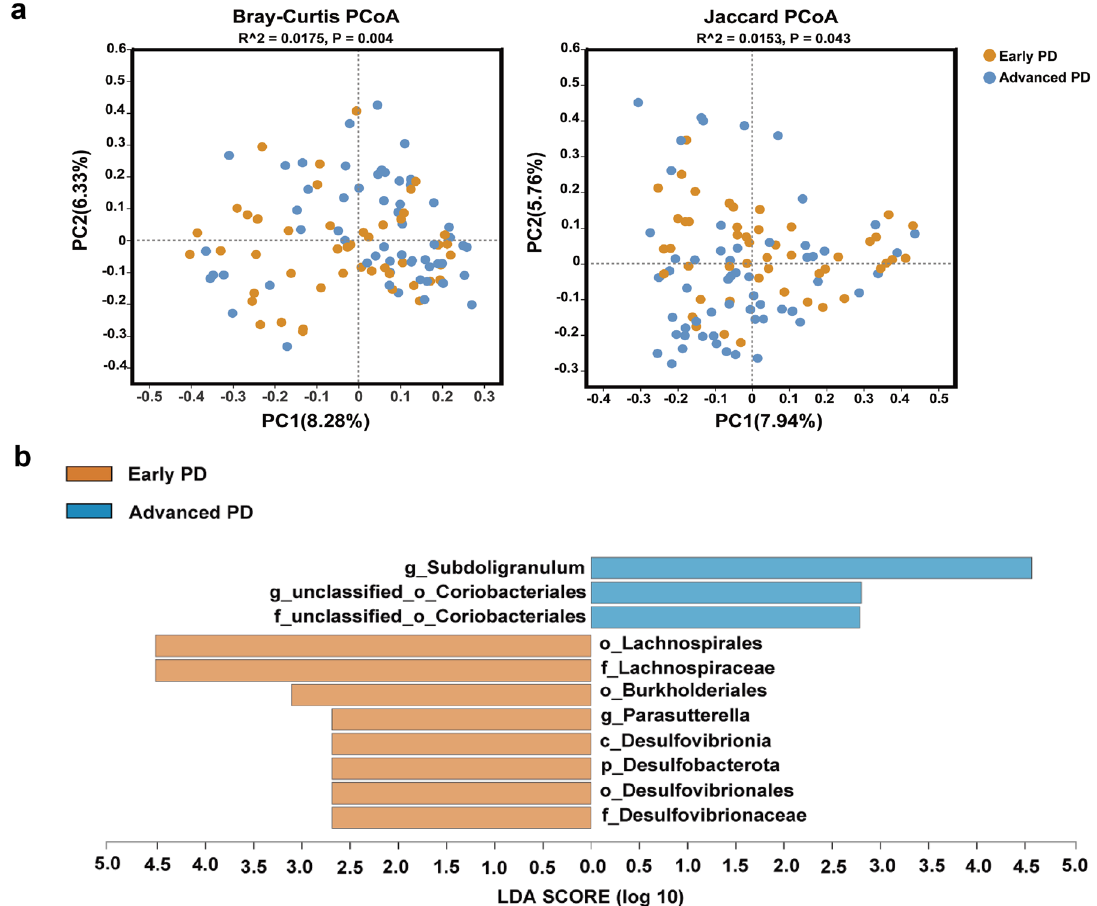
Fig. 2 The alteration of fecal microbiota between early and advanced PD patients. a Beta diversity plots to visualize the difference in microbiota structure between early and advanced PD patients. PCoA plots show the beta-diversity with Bray – Curtis and Jaccard measures. b LEfSe analysis revealed remarkable microbial differences between early and advanced PD patients, adjusting for age, sex, BMI, levodopa (use or no use), levodopa daily dose, and LEDD. Abbreviations: PCoA, principal coordinates analysis; LEfSe, linear discriminant analysis (LDA) effect size; p, phylum; c, class; o, order; f, family; g, genus; BMI, body mass index; LEDD, levodopa equivalent daily